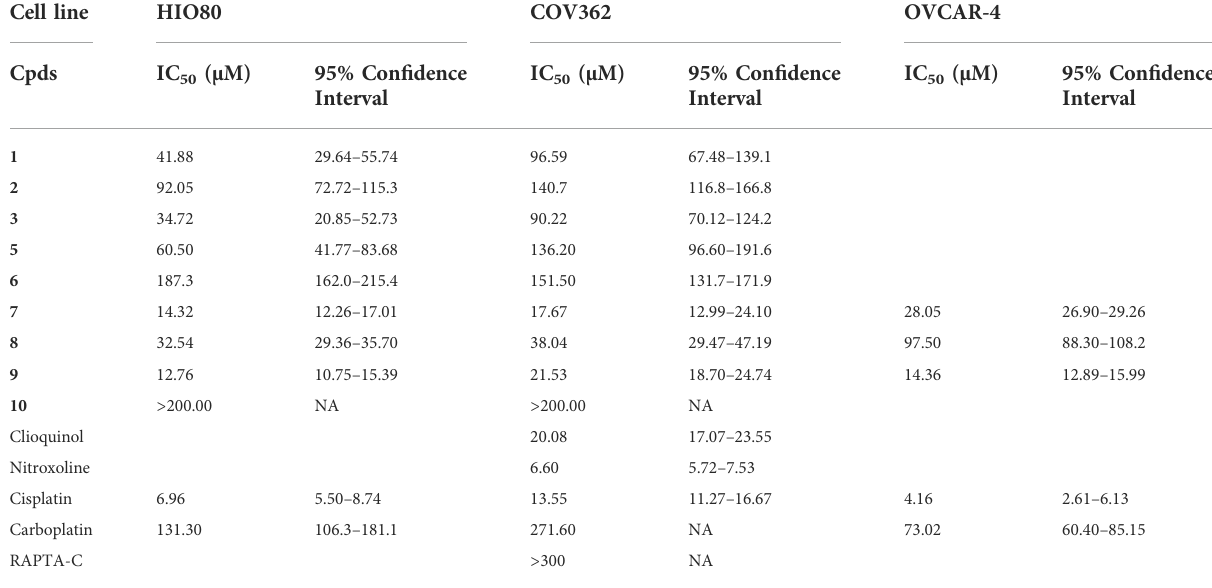
TABLE 2 IC 50 values for HGSOC cell lines COV362 and OVCAR-4 and control cell line HIO80. Cell